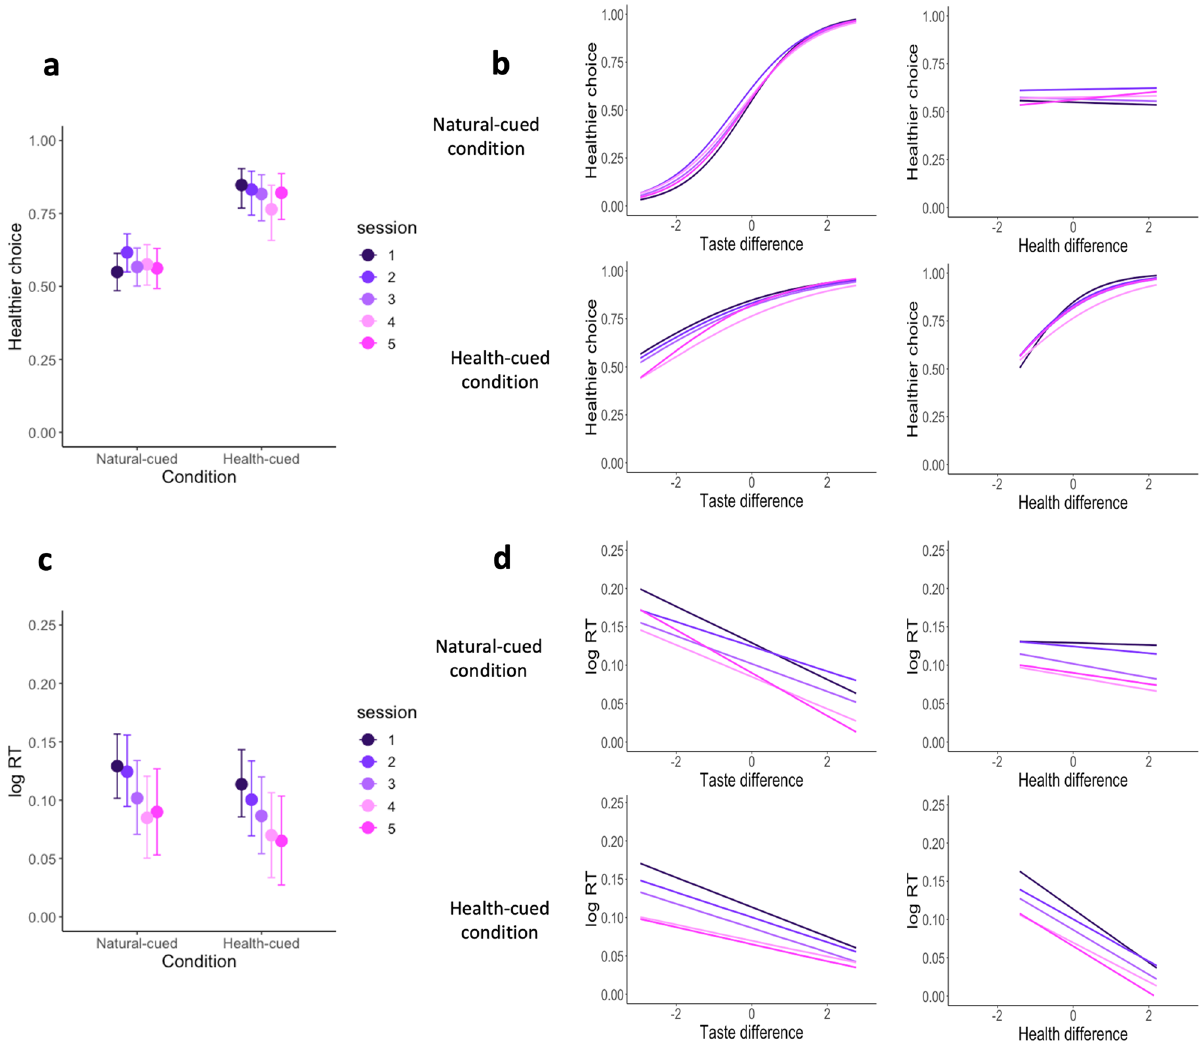
Figure 2. Effects of health-cues and attribute differences on choice outcomes and RTs over the five sessions. ( a , b ) Shows the proportion of healthier choices on the y-axis as a function of condition (health-cued, natural- cued choice) or attribute differences (computed as healthier item minus less-healthy item) on the x-axis. The results in each session are indicated by the separate colors shown in the legend. ( a ) The panel shows that healthier choices were higher in the health-cued condition compared to the natural-cued condition in all five sessions. ( b ) The panel shows how the two attributes (taste and healthiness) relate to choice outcomes in each of the two conditions (natural-cued and health-cued). ( c , d ) are analogous to ( a ) and ( b ) except that they show the logarithm of response times on the y-axis as a function of condition or attribute differences on the x-axis. The error bars in both ( a ) and ( c ) represent the 95%